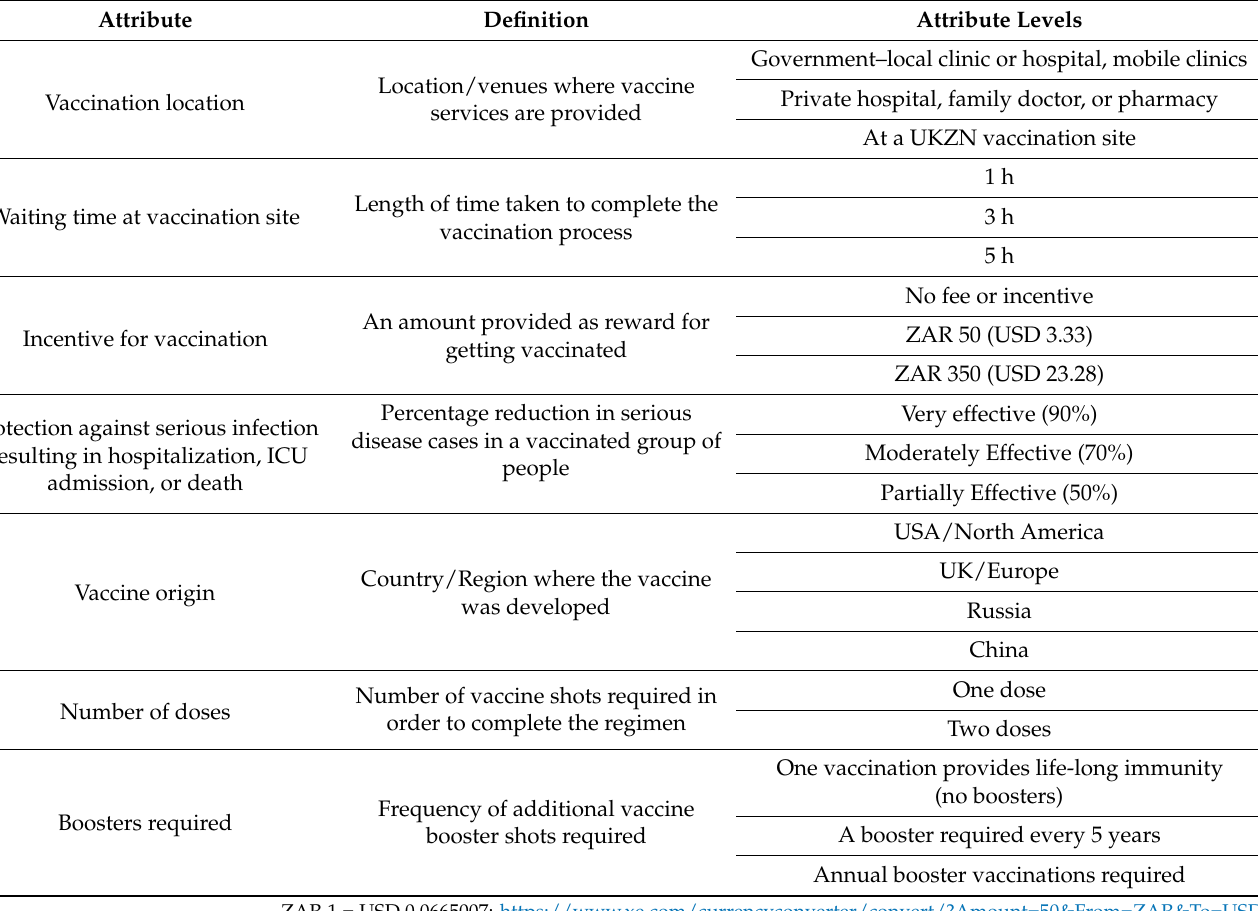
Table 1. Discrete choice experiment attributes and